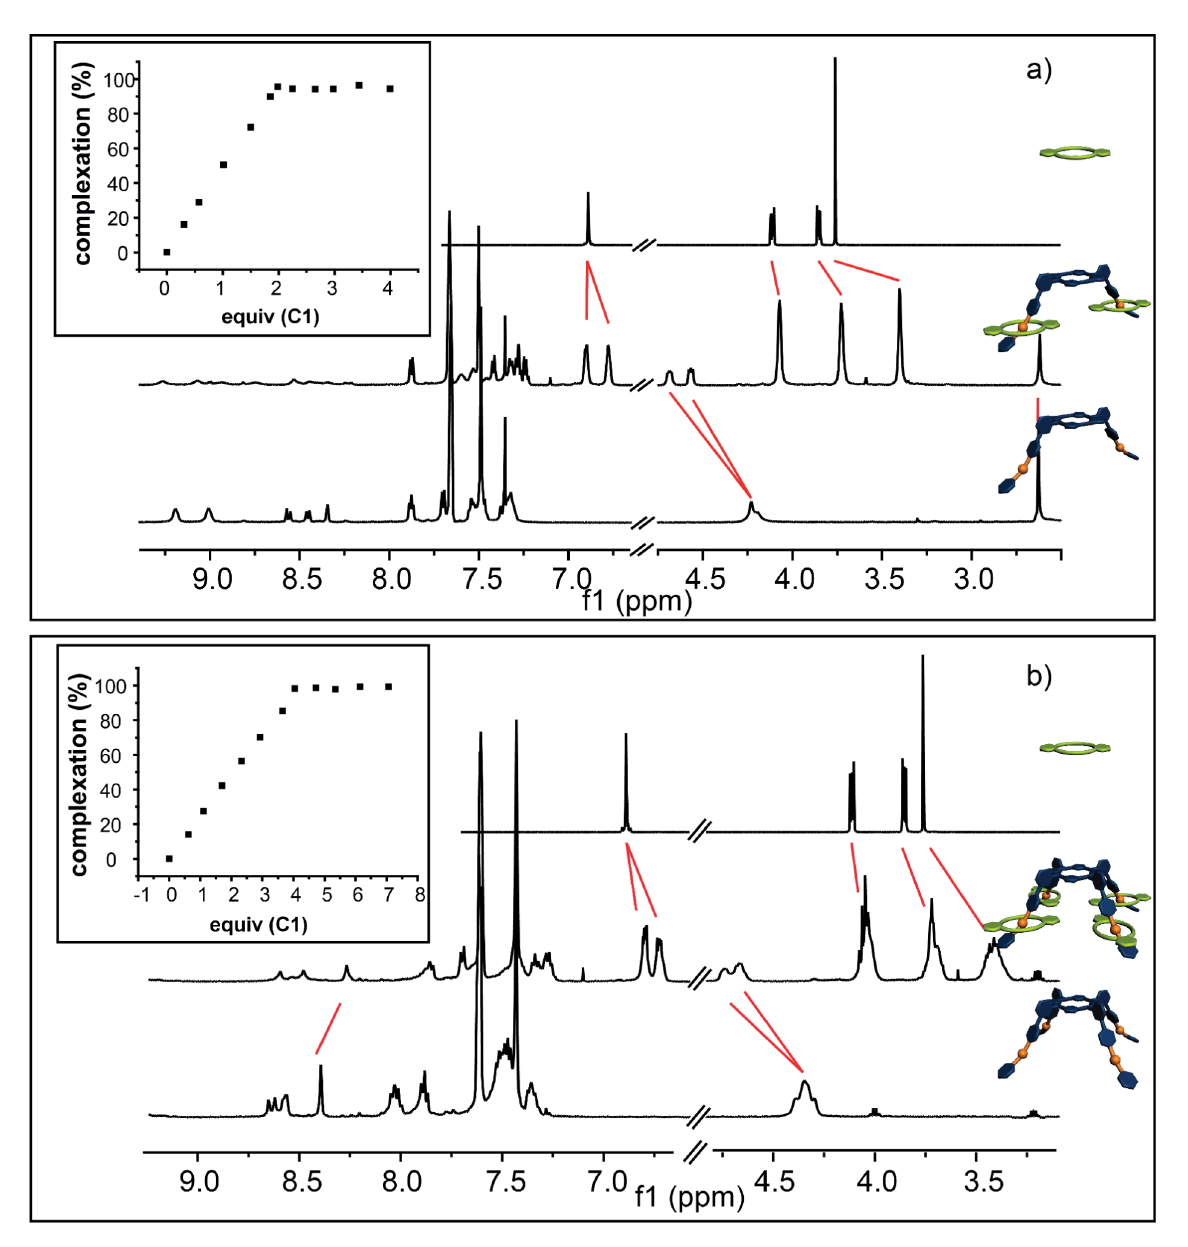
Figure 3: 1 H NMR (500 MHz, 298 K, CD 2 Cl 2 , 3 mM) of a) C1 (top), A2 @ C1 2 (middle) and A2 (bottom); b) C1 (top), A4 @ C1 4 (middle) and A4 (bottom) showing clear evidence of the complexation. The red lines indicate the shift of the proton signals upon addition. The inserts show the titra- tion curve of each complexation with the expected ratio of the complex